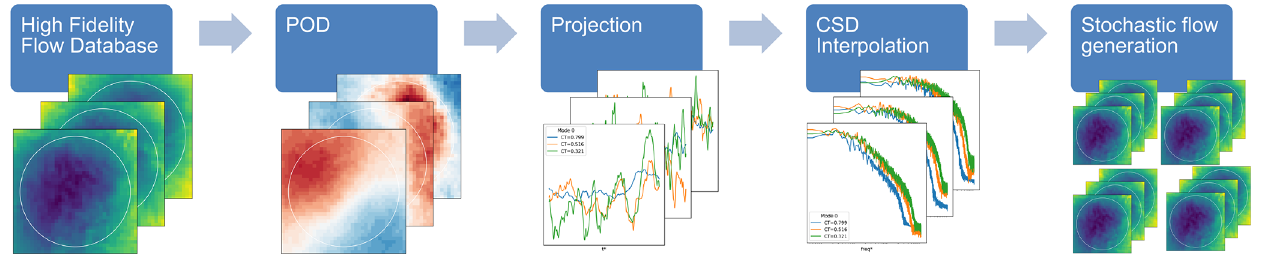
Figure 1. Five steps of the predictive stochastic reduced-order